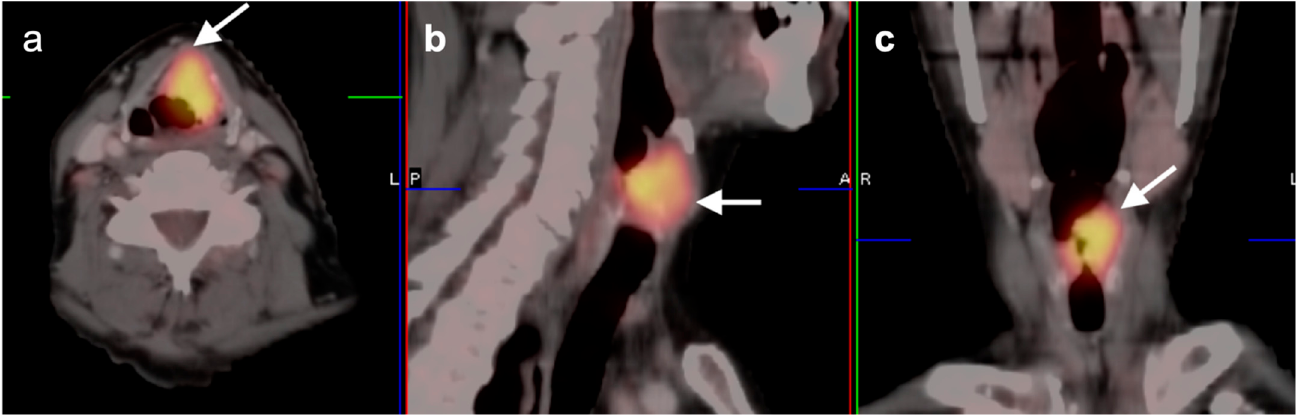
Figure 17. Squamous cell carcinoma of the false cords. ( a ) A large tumor shown in axial ( a ), sagittal ( b ) and coronal ( c ) FDG PET-CT images (white arrows) involves the left false cord and extends across the anterior midline to involve and anterior aspect of the right false cord. The mass effaces the left pyriform sinus and extends to the base of the epiglottis.